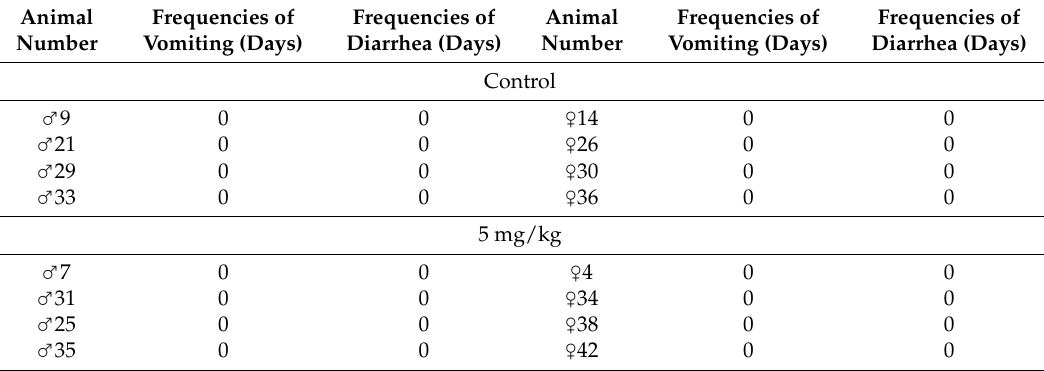
Table 1. Selected clinical signs induced by HZ1006 in dogs following repeated dose administration during the study of subchronic toxicity (only data regarding the frequencies of vomiting and diarrhea during test time are